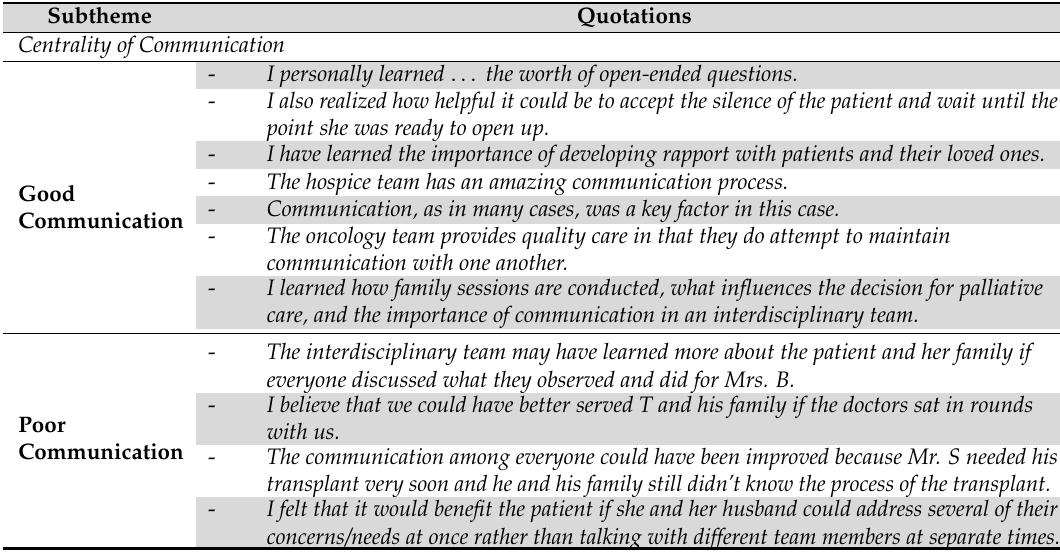
Table 6. Quotes related to the subtheme of the centrality of